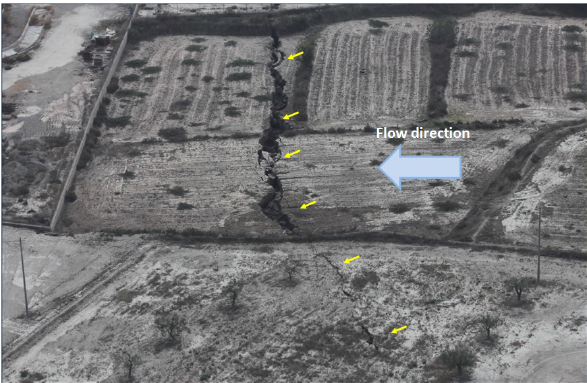
Figure 5. Aerial view of the third and second northern sections of the crack (courtesy of Puerto Lumbreras City Council). The yellow arrows indicate the location of the earth fissure (modified from Mu- las,